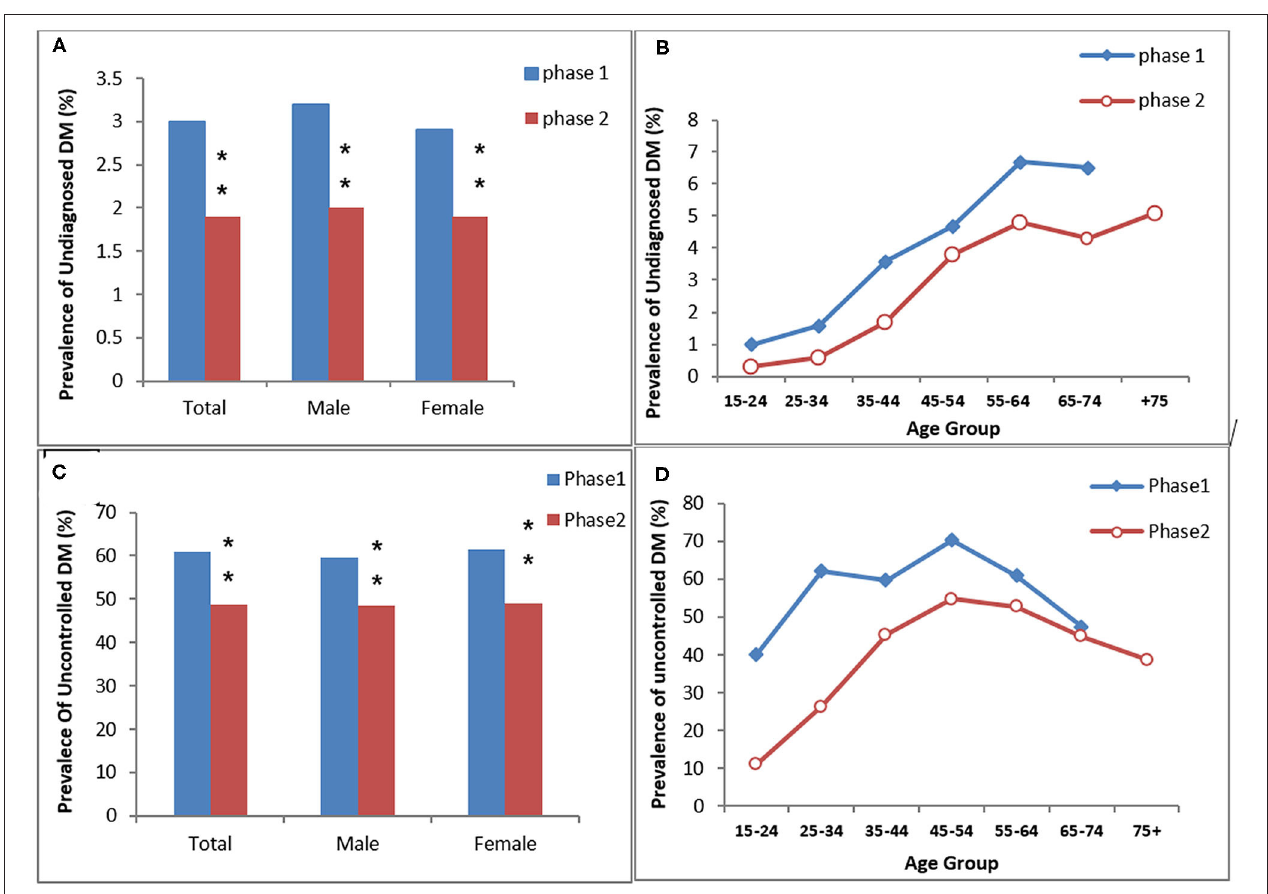
FIGURE 3 | The prevalence of undiagnosed DM (A,B) and uncontrolled DM in the diagnosed diabetic participants (C,D) in the study (KERCADRS) by sex and age groups. Total participants were 9,957 in phase 2 and 5,900 in phase 1. The data of phase 1 were used here for comparison and are extracted from our paper published previously ( 20). ** P < 0.01 compared to phase